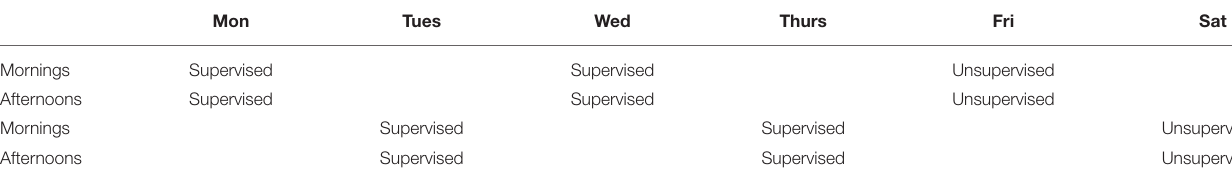
TABLE 1 | Time schedules for conducting the intervention.